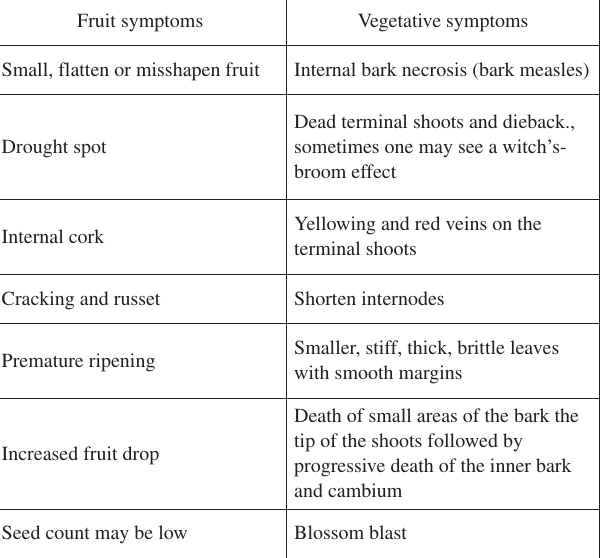
Table 2. Common fruit and vegetative boron deficiency